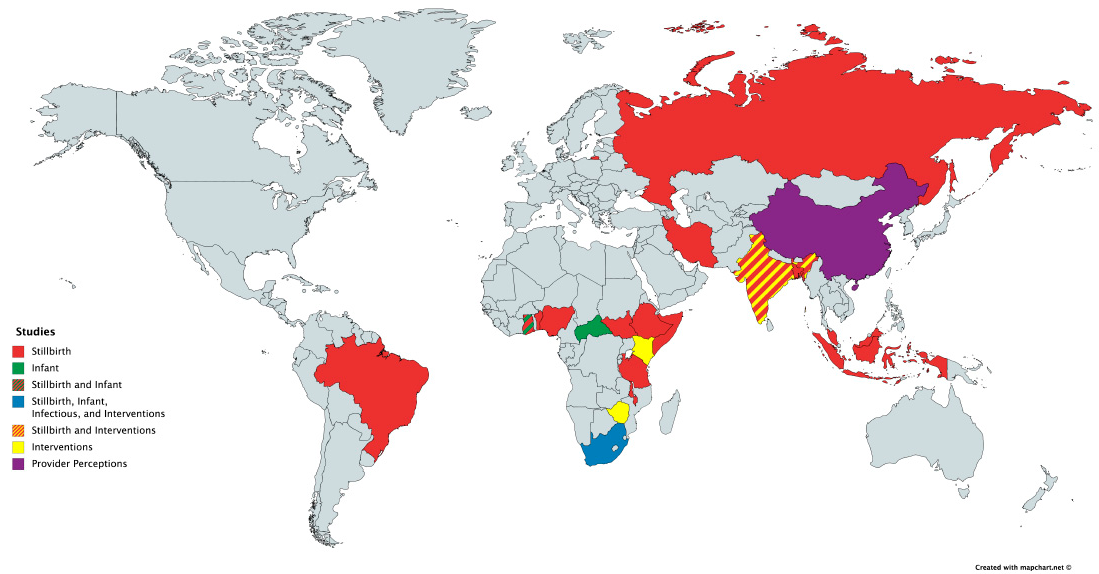
Figure 1. World map with study location and type.